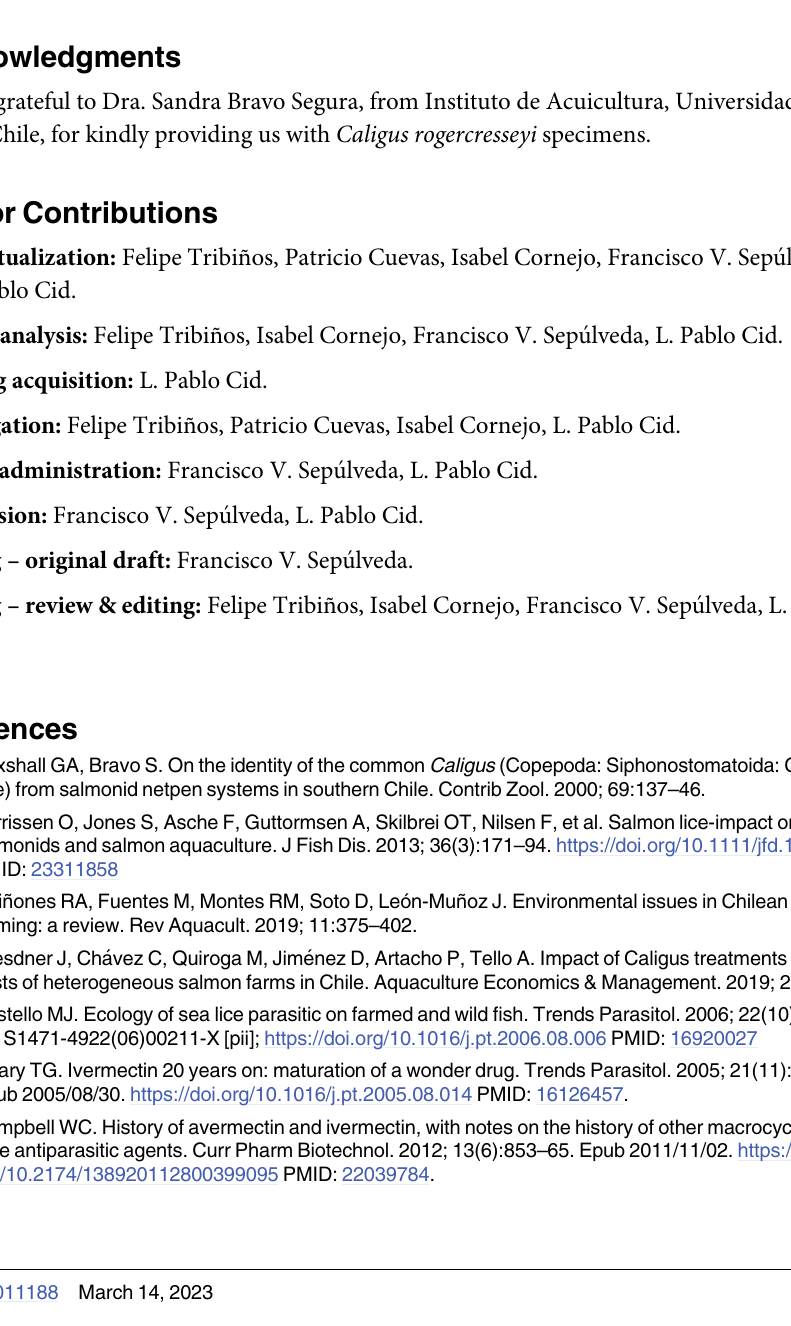
S1 Table. Primers used in cloning CrGluCl subunits. S1 Fig. Schematic representation of GluCl transcripts from database mining. S2 Fig. Comparison of Caligus rogercresseyi GluCl subunits with putative Lepeophtheirus salmonis GluCls predicted amino acid sequences. S3 Fig. Effect of emamectin on the response of CrGluCl-B to